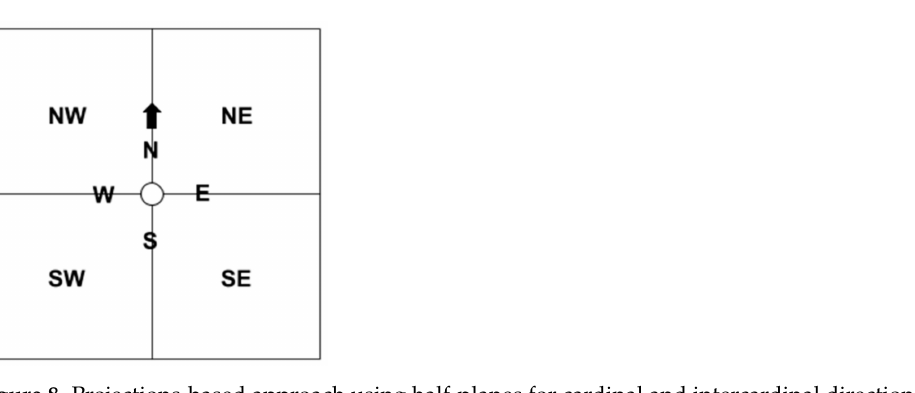
Figure 8. Projections-based approach using half-planes for cardinal and intercardinal directions, as modeled in